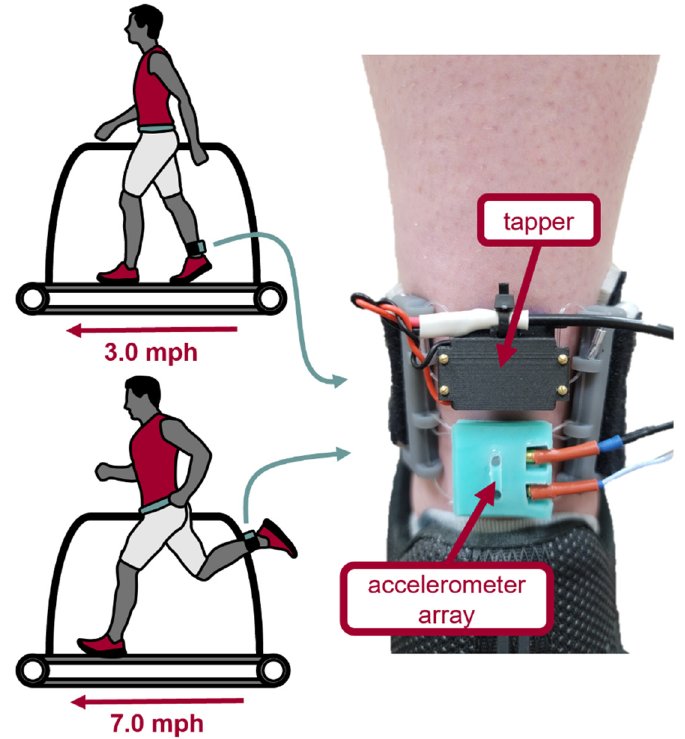
Figure 6. The participant walked (3.0 mph) and ran (7.0 mph) on a treadmill. The shear wave tensiometer was placed over the right Achilles tendon. The tensiometer consisted of a tapper driven by an electrodynamic surface transducer (SparkFun Electronics, Niwot, CO, USA) and two miniature accelerometers (PCB Piezotronics, Depew, NY, USA) affixed in a silicone holder.